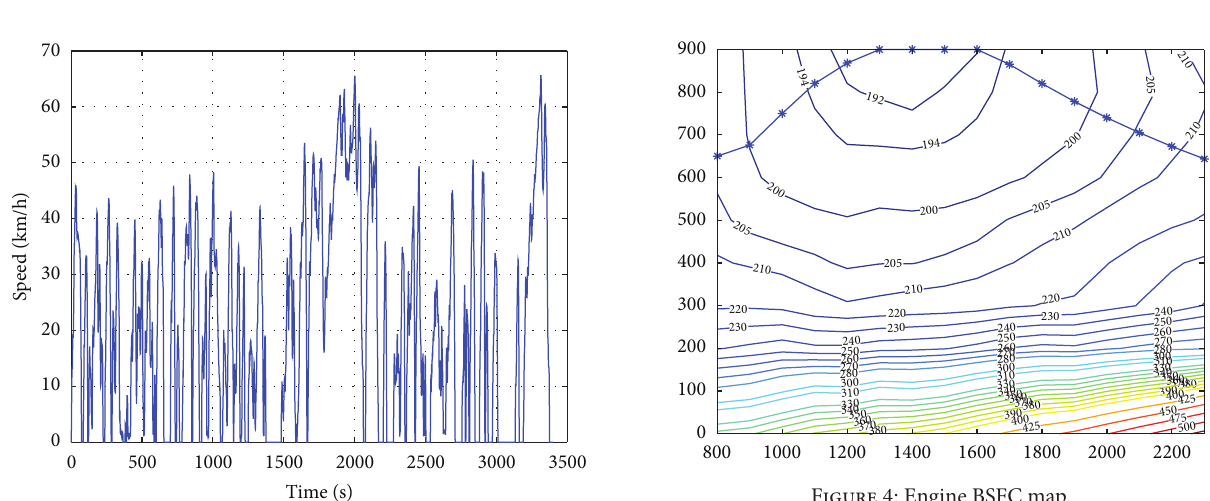
Figure 4: Engine BSFC